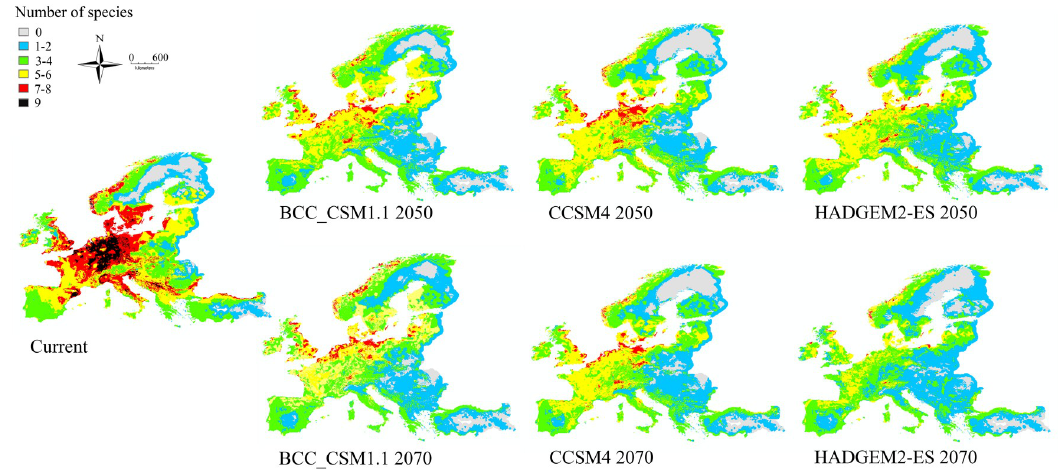
Fig 4. Spatial distributions of predicted current and future (2050 and 2070) species richness based on the BCC_CSM1.1, CCSM4 and HadGEM2-ES climate models.